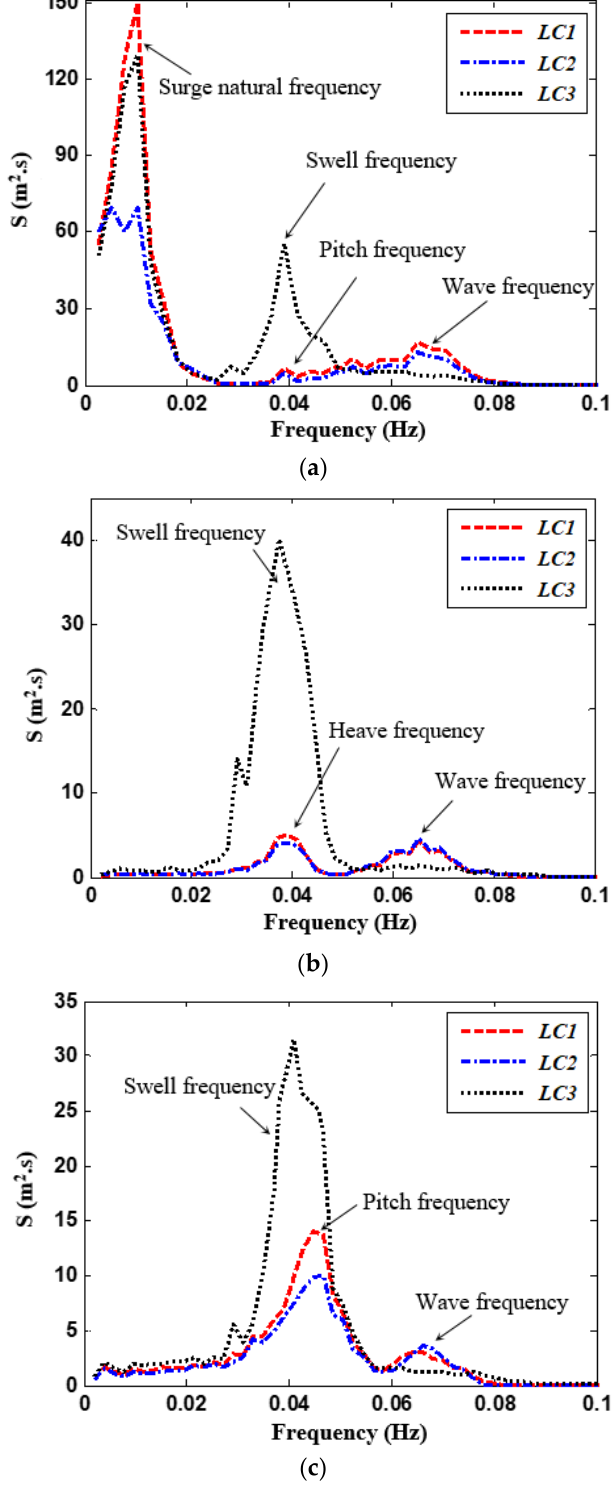
Figure 17. Response power spectra of WSA motions in three load cases: ( a ) surge; ( b ) heave; ( c ) pitch.